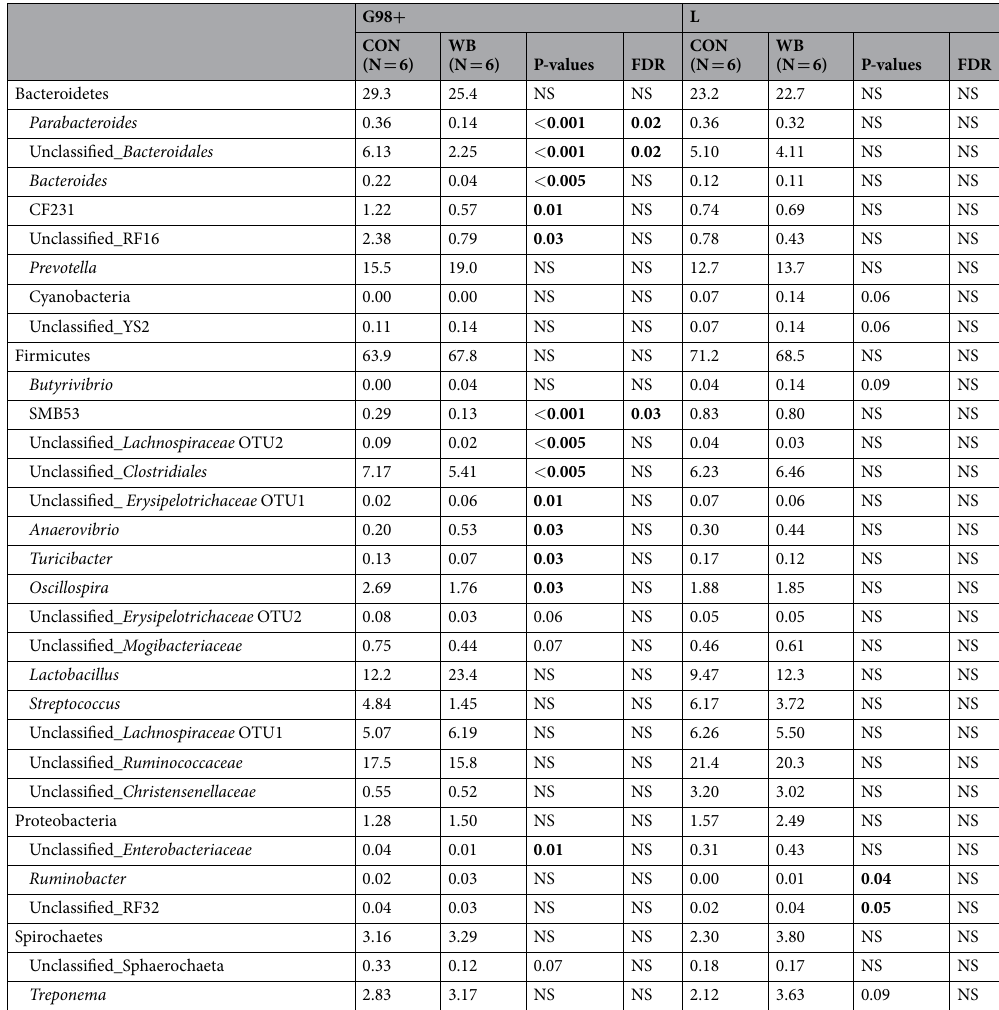
Table 1. Composition of the faecal microbiota of sows fed the control diet (CON, N = 6) and the wheat bran-enriched diet (WB, N = 6) at two different stages: 98 d into gestation (G98 + ) and 20 d into lactation (L), expressed as a percentage (%) of the total microbiota. Only genera with a relative abundance > 0.01% were included in this table. P-values and FDR were considered as non-significant (NS) when p > 0.1 and consistent when 0.05 < p <